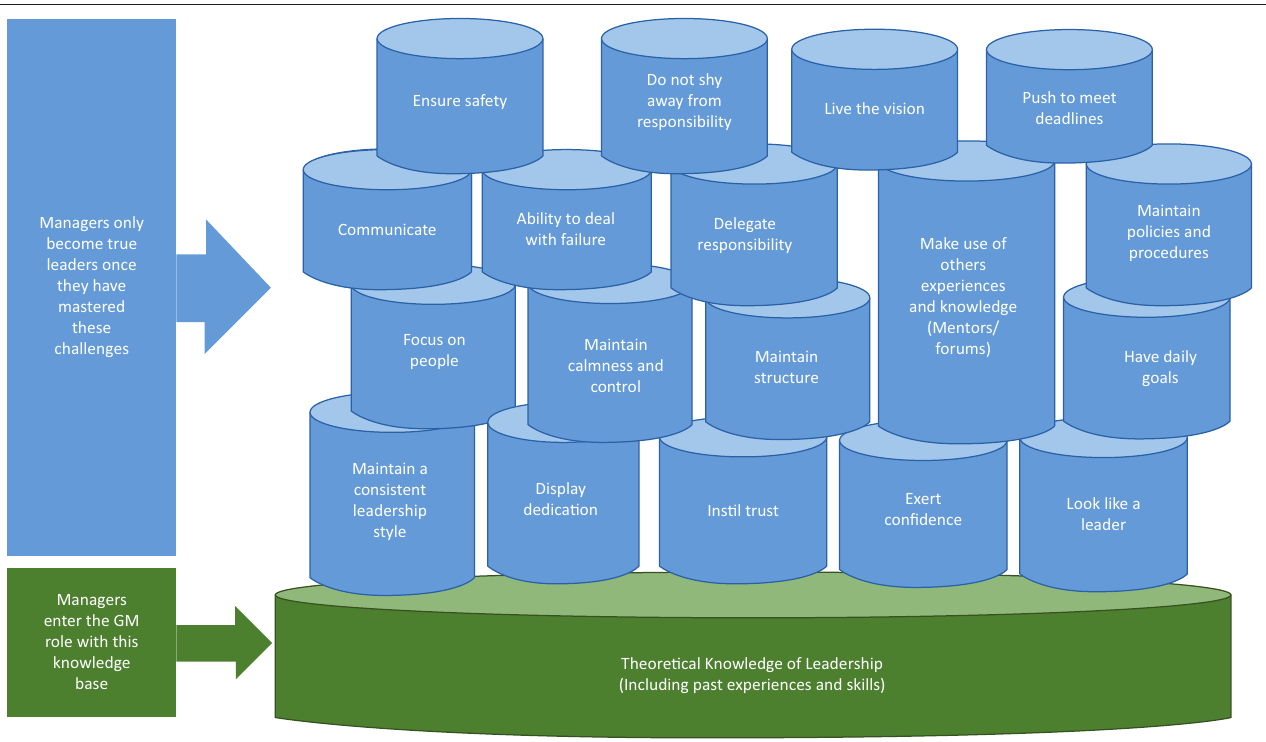
FIGURE 3: Mastering the leadership role (coded from verbatim